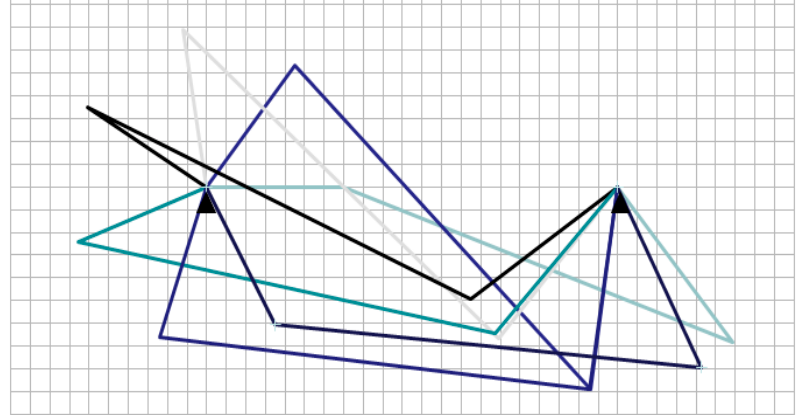
Figure 9. Crank–rocker four-bar linkage flapping mechanism.